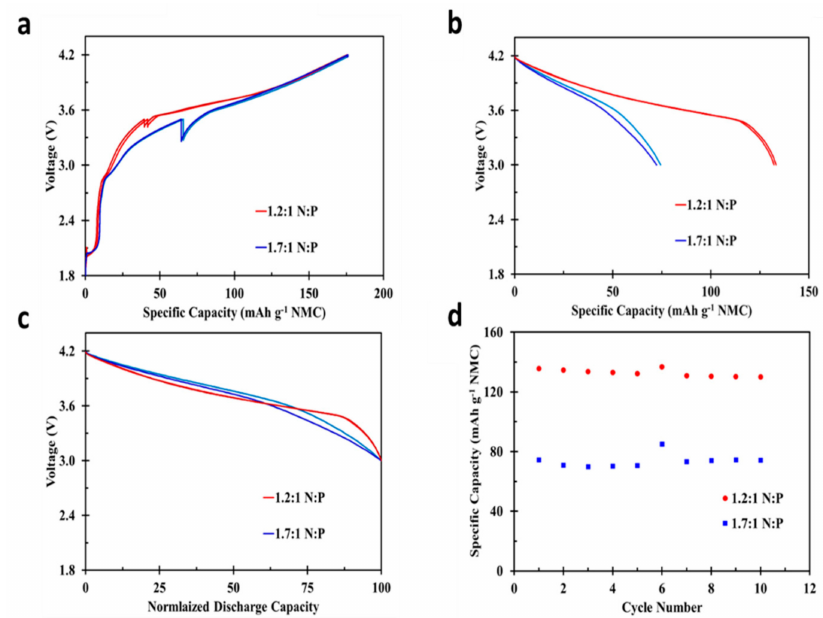
Figure 4. ( a ) The first charge capacity and ( b ) discharge voltage profiles for NMC/MCMB cells with 1.2:1 and 1.7:1 N:P capacity ratio, ( c ) normalized discharge voltage profiles and ( d ) cycling results for cells with varied N:P